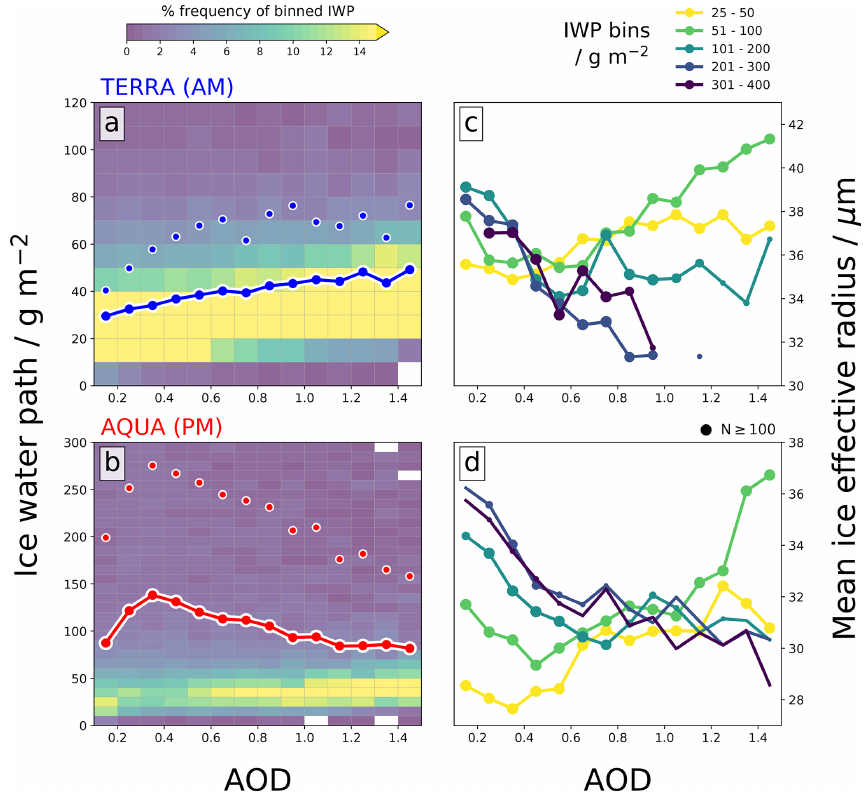
Figure 7. MODIS ice water path (IWP) as a function of AOD (a, b) and MODIS mean ice effective radius binned by IWP as a function of AOD (c, d) for the TERRA (a, c) and AQUA overpasses (b, d) . Joint histograms show % the frequency of IWP binned by AOD, and coloured lines (individual circles) show the geometric (arithmetic) mean in each AOD